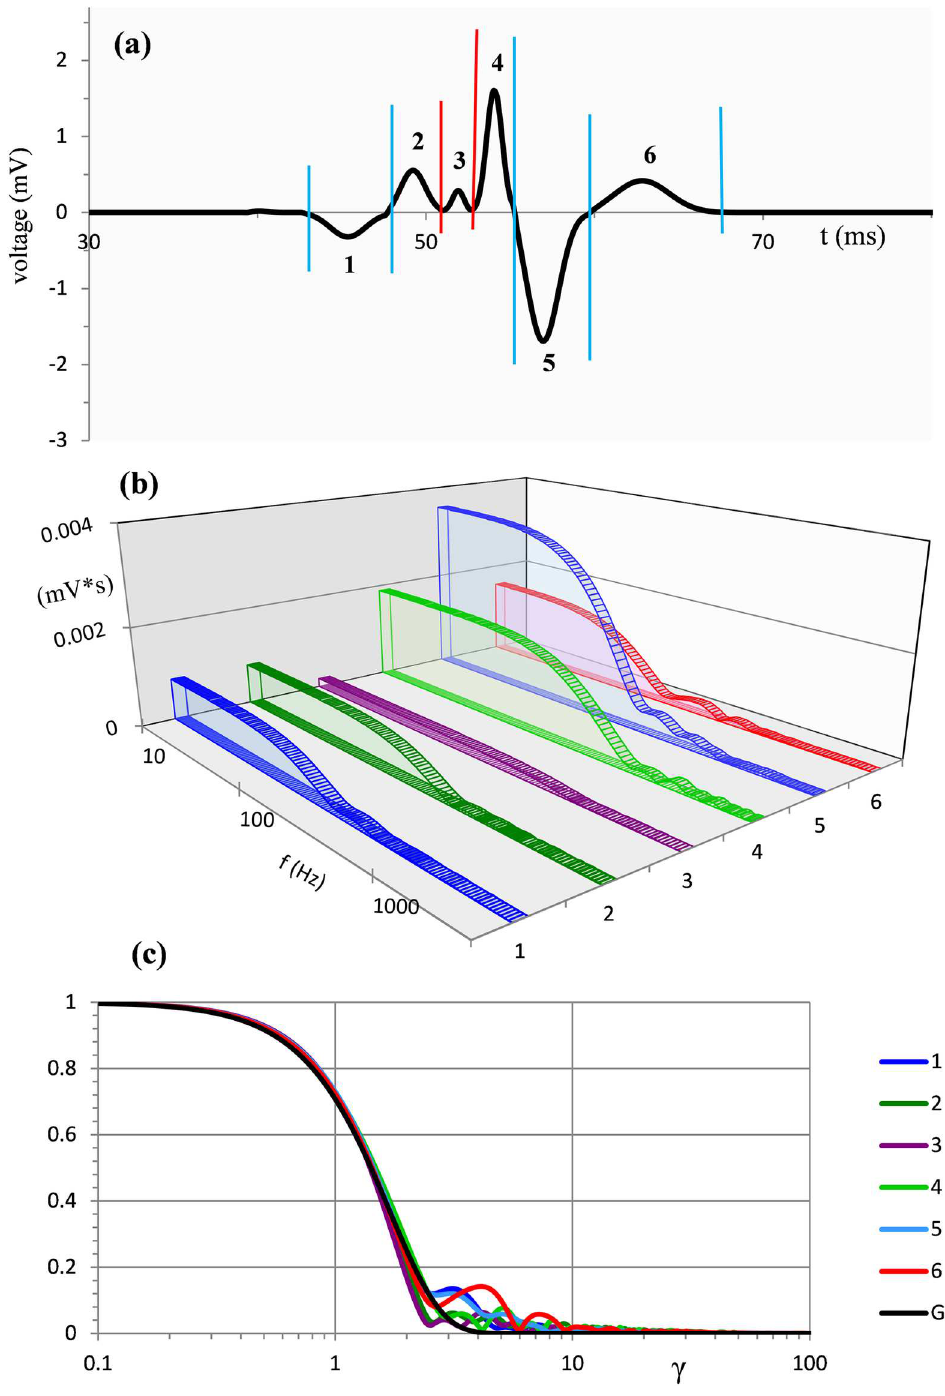
Fig 1. Typical eye-blink EMG in the time and frequency domains. (a) Record of single trial eye-blink EMG in the time interval starting 30 ms after stimulus onset. Vertical lines indicate segmentation points. (b) Amplitude spectra of component waveforms 1–6 from (a). (c) Coloured lines are the amplitude spectra from (b) after normalization of both amplitude and frequency. The black line shows the Gaussian function G( γ ).